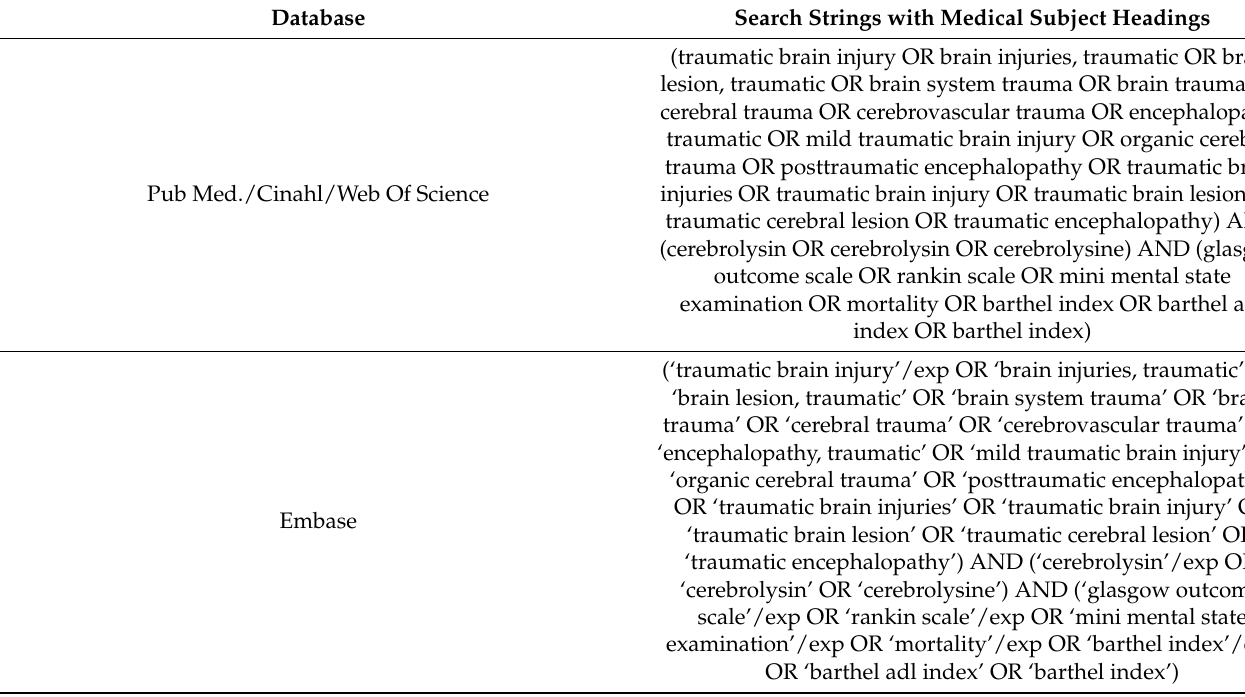
Table 1. Strings used in databases search. Database Search Strings with Medical Subject